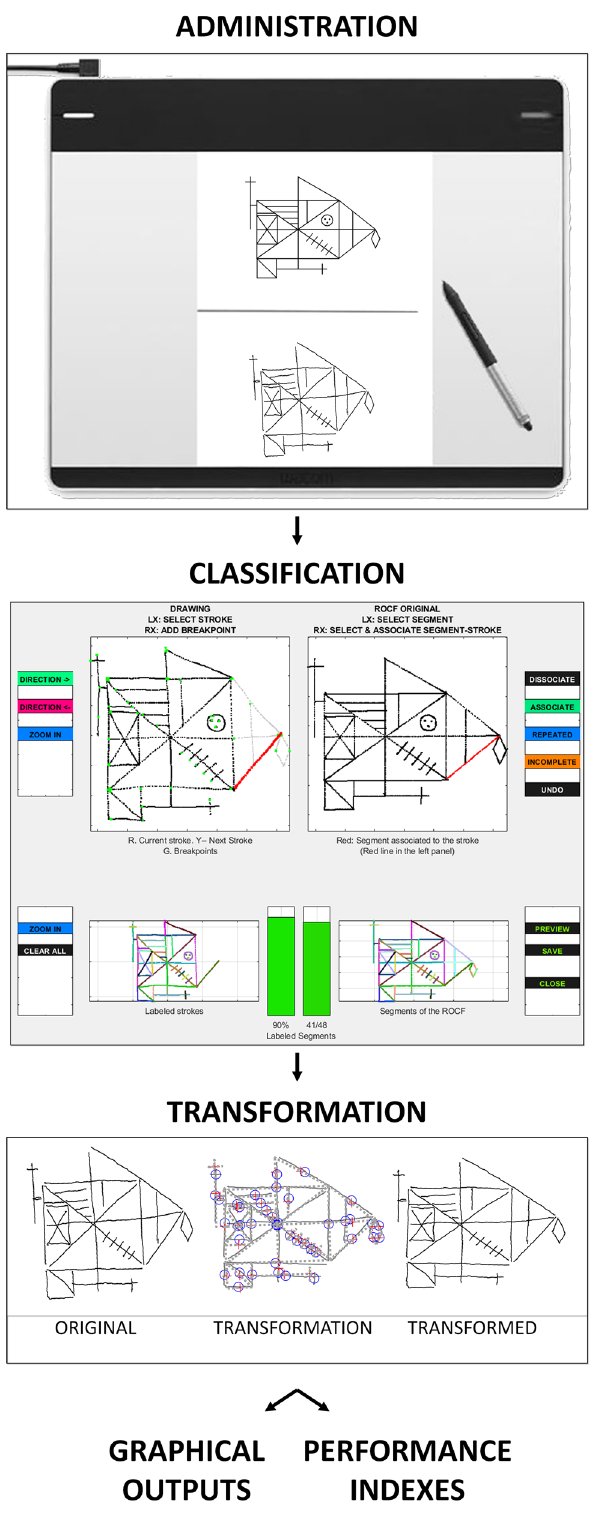
Figure 2. Steps of the T-RCF system. (1) Administration: during the copy of the T-RCF (i.e., Tablet-based Rey complex figure), every pen-surface contact is recorded over time via a graphics tablet connected to a computer. (2) Classification: after administering the task, a classification program is adopted to assist the manual classification of the segmented strokes into the 48 basic elements of the T-RCF. (3) Pre-processing: in this stage, the digital recording of the copy is subjected to a transformation process aimed at eliminating global distortion of the copy output. (4A) Graphical outputs: the T-RCF system produces three graphical outputs: a reproduction of the final graphic result (i.e., graphic output), a visual representation of the velocity profile (i.e., velocity output), and a visual representation of the drawing sequence (procedure output). (4B) Performance indexes: finally, the T-RCF scoring system computes the 12 indices of performance. The figures are created using Matlab (version 2017b, The Mathworks, Natick, MA, USA, www. mathw orks. com)